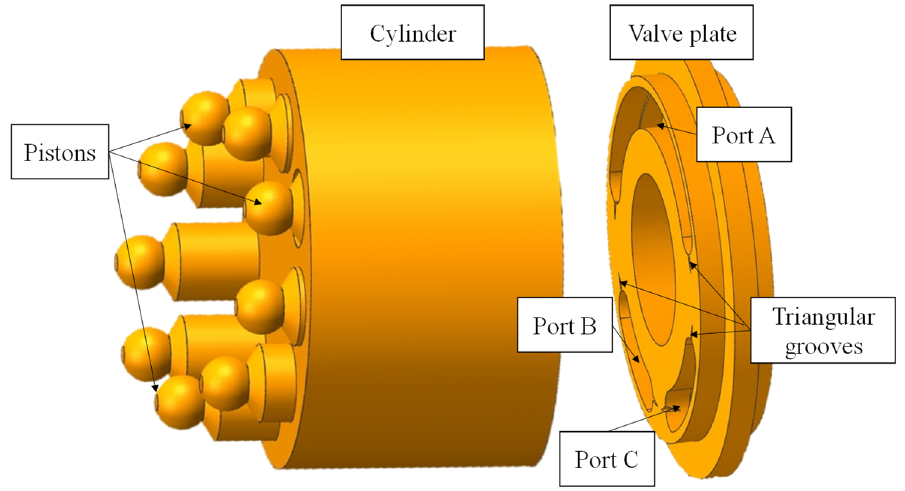
Figure 1. cylinder and valve plate.